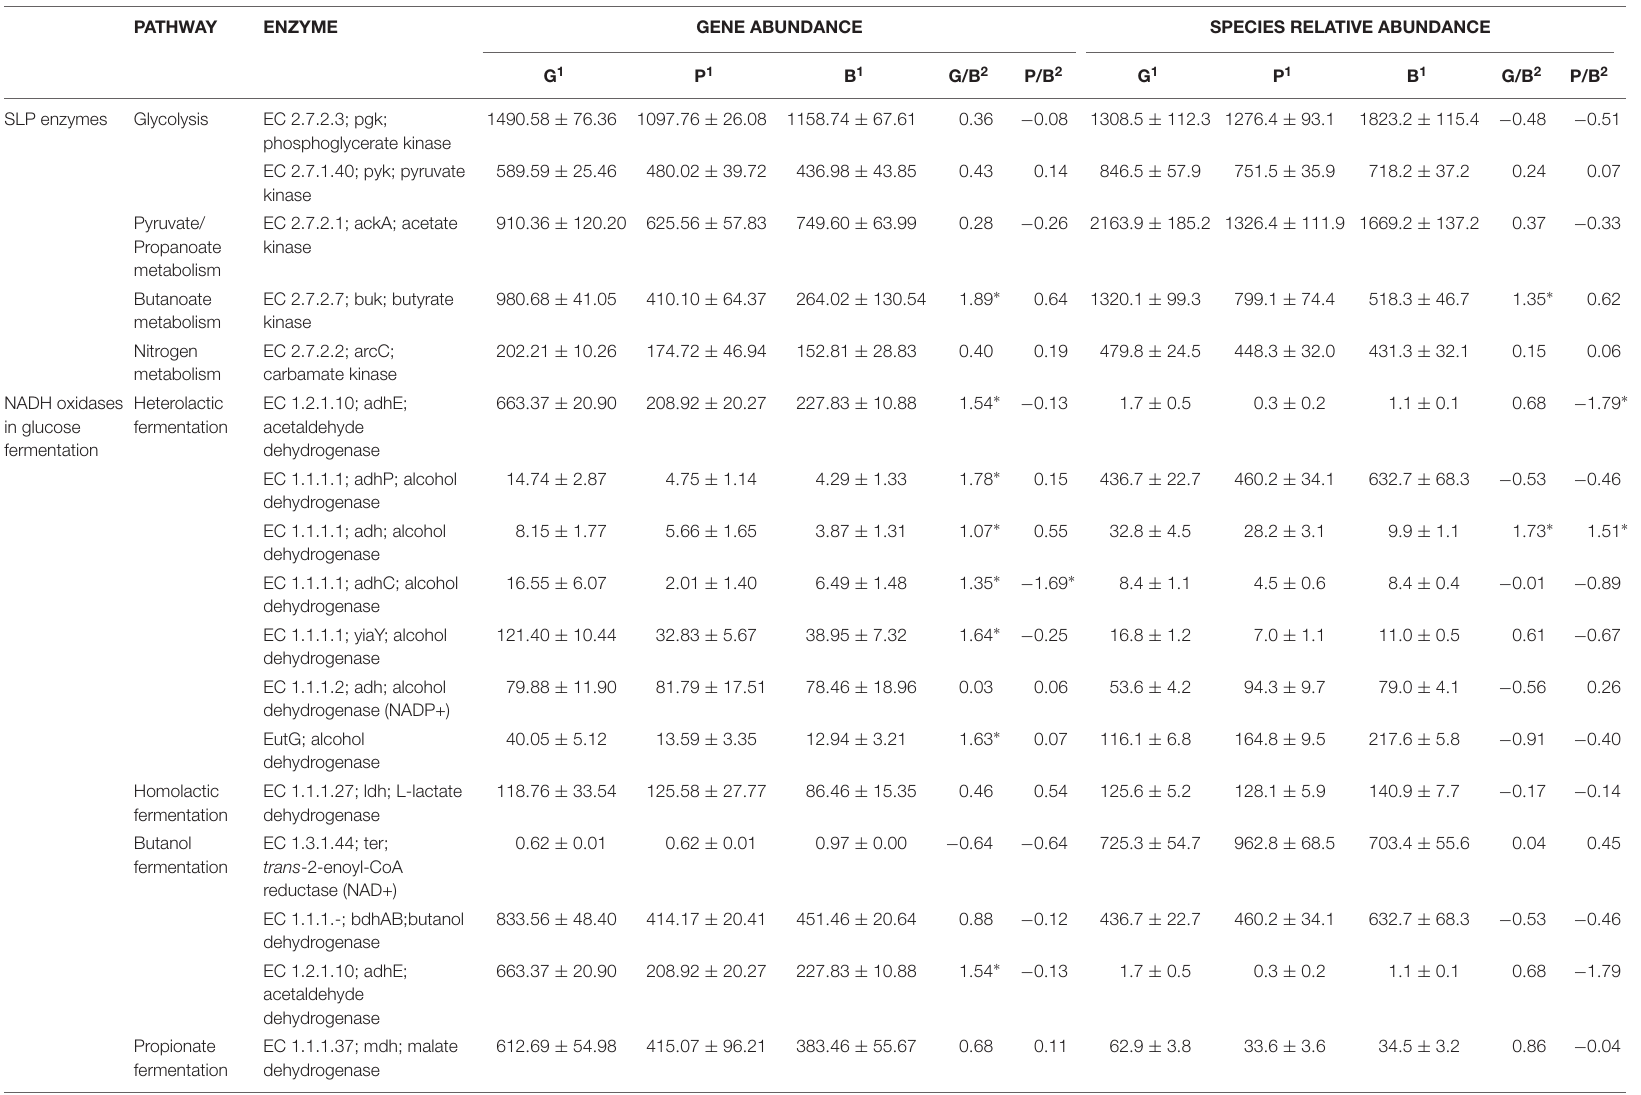
TABLE 2 | Comparisons of the abundances of SLP enzymes, ETC components, and NADH oxidases during glucose fermentation and of the relative abundance of corresponding species between